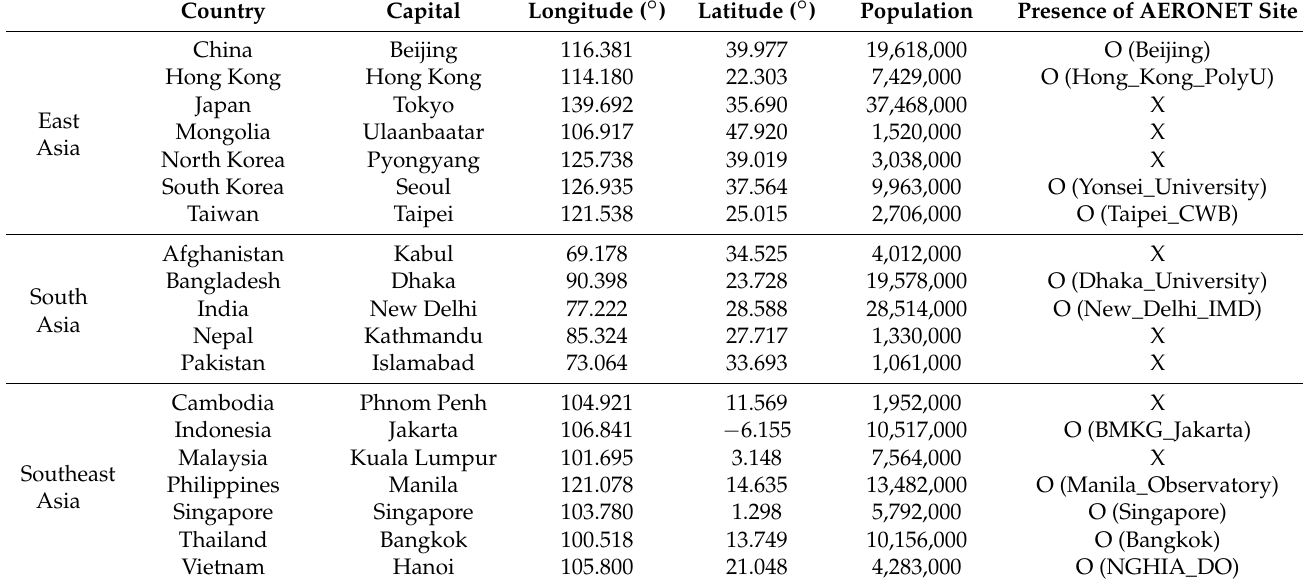
The regions of interest were selected from capital cities in East Asia, South Asia, and Southeast Asia with populations of >1 million. About 40% of the 19 capitals lack an AERONET observation site (Table 1). To simultaneously compare AERONET and satellite observation data, the location of the AERONET site was used as the location of the corresponding city, with satellite data for near that location being collected. For cities with no AERONET site, coordinates were obtained from the GeoHack system of Wikitech (https://geohack.toolforge.org/, accessed on 20 April 2021). Table 1. Regions of interest containing capital cities in East Asia, South Asia, and Southeast Asia with populations of >1,000,000 [47]. The coordinates of cities are those of an AERONET site; coordinates of cities without AERONET sites were obtained from the GeoHack system of Wikitech (https://geohack.toolforge.org/, accessed on 20 April 2021). Country